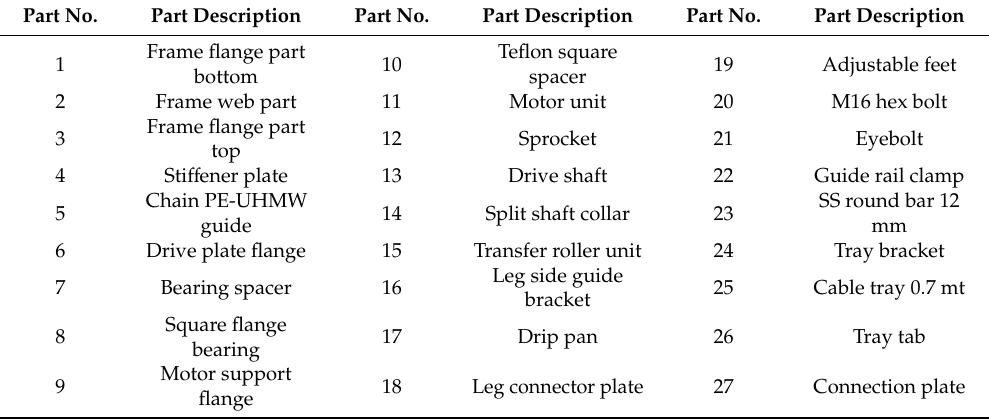
Figure 14. Exploded diagram for ‘Drive straight section new’. Table 5. Part description for ‘Drive straight section new’.